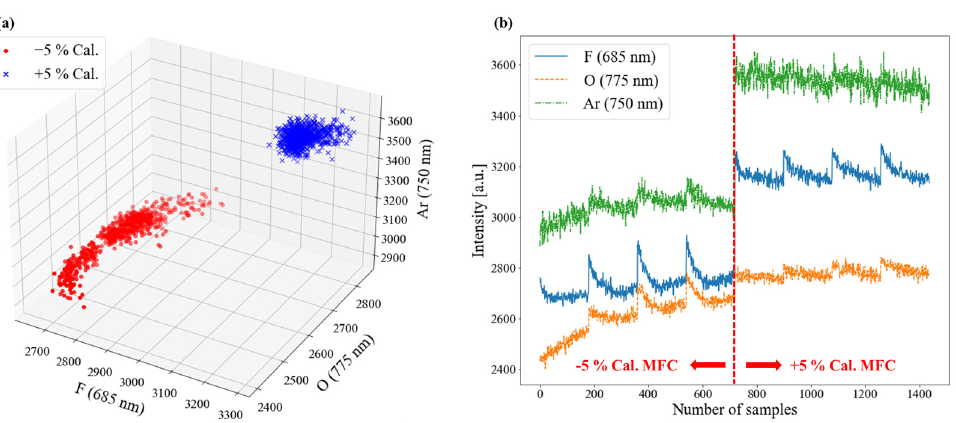
Figure 8. OES data of experiments for the mis-calibrated MFC; ( a ) 3D plot with each mis-calibrated MFC, and ( b ) variation of OES intensity.